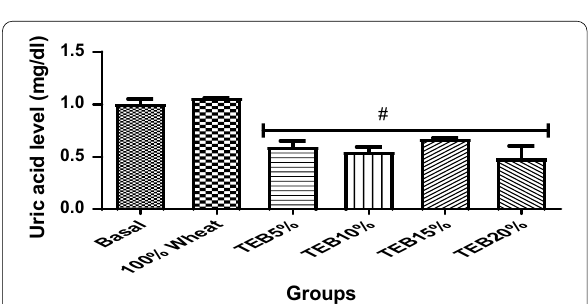
Fig. 10 Effects of enzymatic tacca–wheat biscuit on albino Wistar rats by uric acid. Basal: Rats fed with animal chow. 100% Wheat: Rats fed with 100% wheat flour biscuit, TEB5%: Rats fed with 5% enzymatic tacca flour 95% wheat flour biscuit, TEB10%: Rats fed with 10% + enzymatic tacca flour 90% wheat flour biscuit, TEB15%: Rats fed + with 15% enzymatic tacca flour 85% wheat flour biscuit, TEB20%: + Rats fed with 20% enzymatic tacca flour 80% wheat flour +